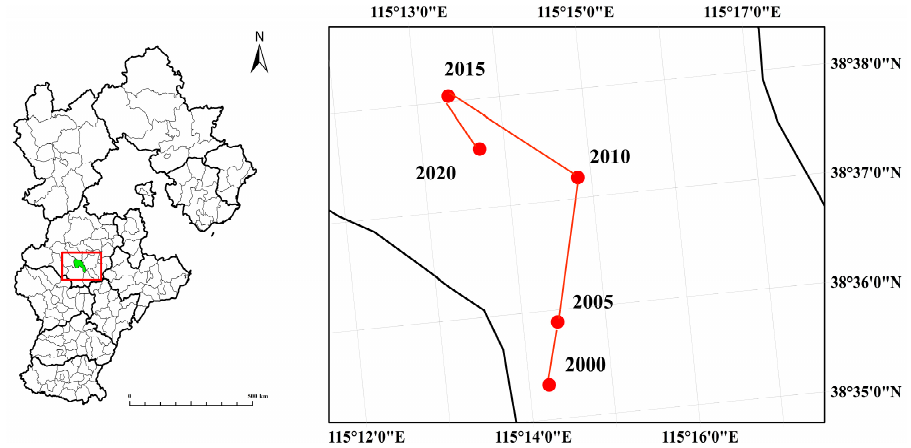
Figure 6. Variation in the trajectory of gravity centers of WLF nexus system in Hebei Province.